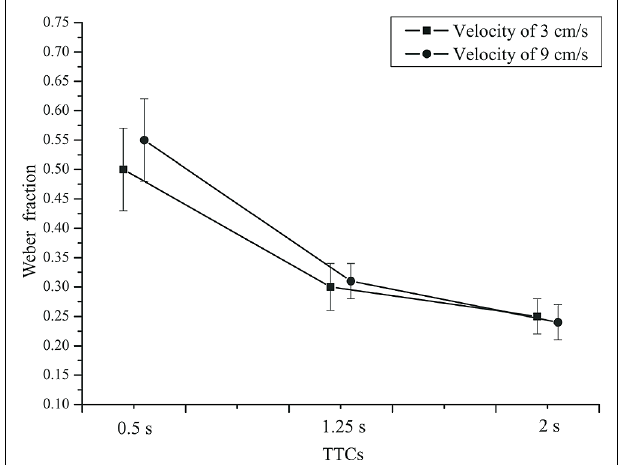
FIGURE 7 | MeanWeber fractions as a function ofTTC and velocity. Squares: 3 cm/s. Circles: 9 cm/s. Error bars: 95% CIs.